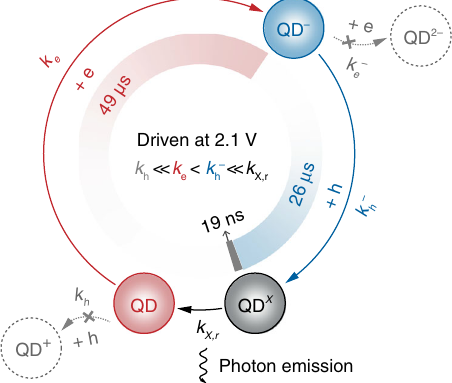
Fig. 3 Dynamics of the single-dot EL cycle. EL of a single QD at 2.1 V consists of three elementary steps, i.e., electron injection into the neutral = 2.0 × 10 4 s − 1 ), hole injection into the QD (red arrow, rate coef fi cient: k e = 3.8 × 10 4 s − 1 ) and negatively charged QD (blue arrow, rate coef fi cient: k (cid:2) h = 1/ radiative recombination of an exciton (black arrow, rate coef fi cient: k X ; r þ h 19 ns − 1 ). At 2.1 V, hole injection into the neutral QD ( QD ! QD þ ) or þ e electron injection into the negatively charged QD ( QD (cid:2) ! QD 2 (cid:2) ) is negligible according to spectroscopic results. Residence times of the three states, i.e., characteristic times of three elementary processes, are illustrated, indicating a long-lived intermediate state of QD (cid:2)